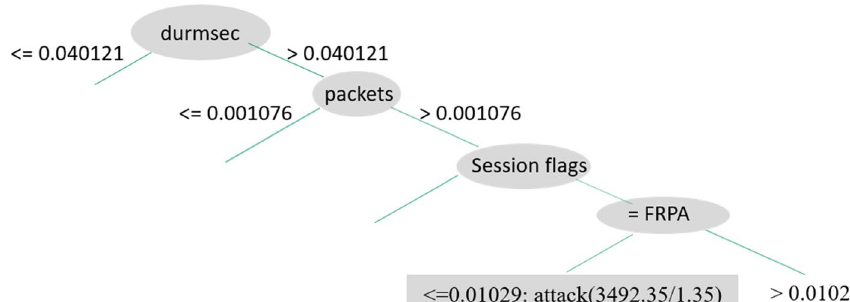
Fig. 8 C4.5D model tree 2